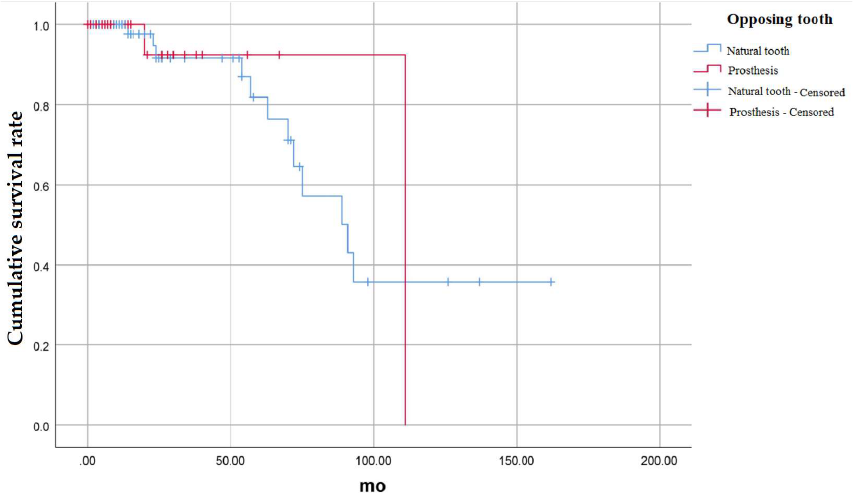
Figure 4. Cumulative survival rate of auto-transplanted tooth according to the condition of oppos- ing teeth.